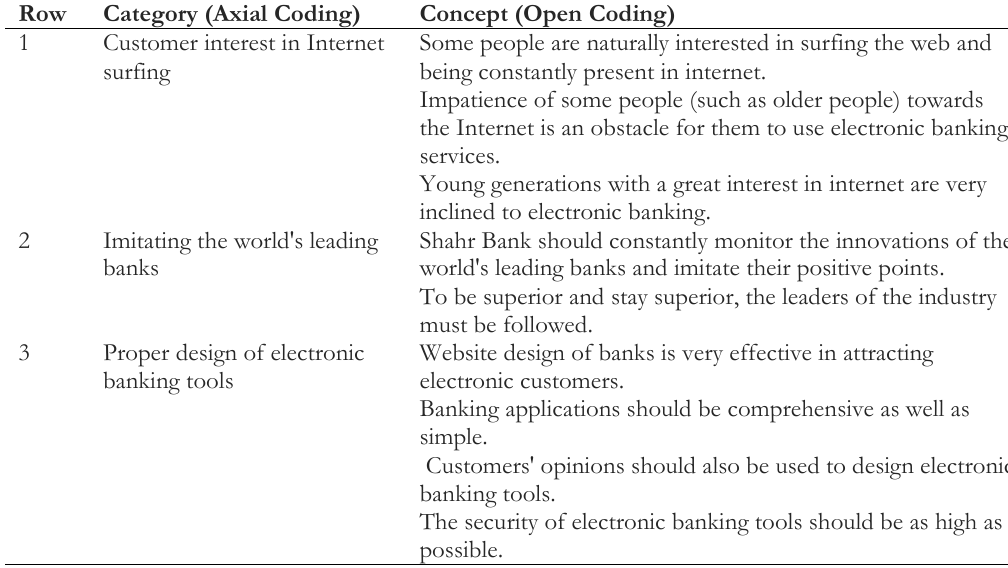
Table 2. The identified categories with relevant